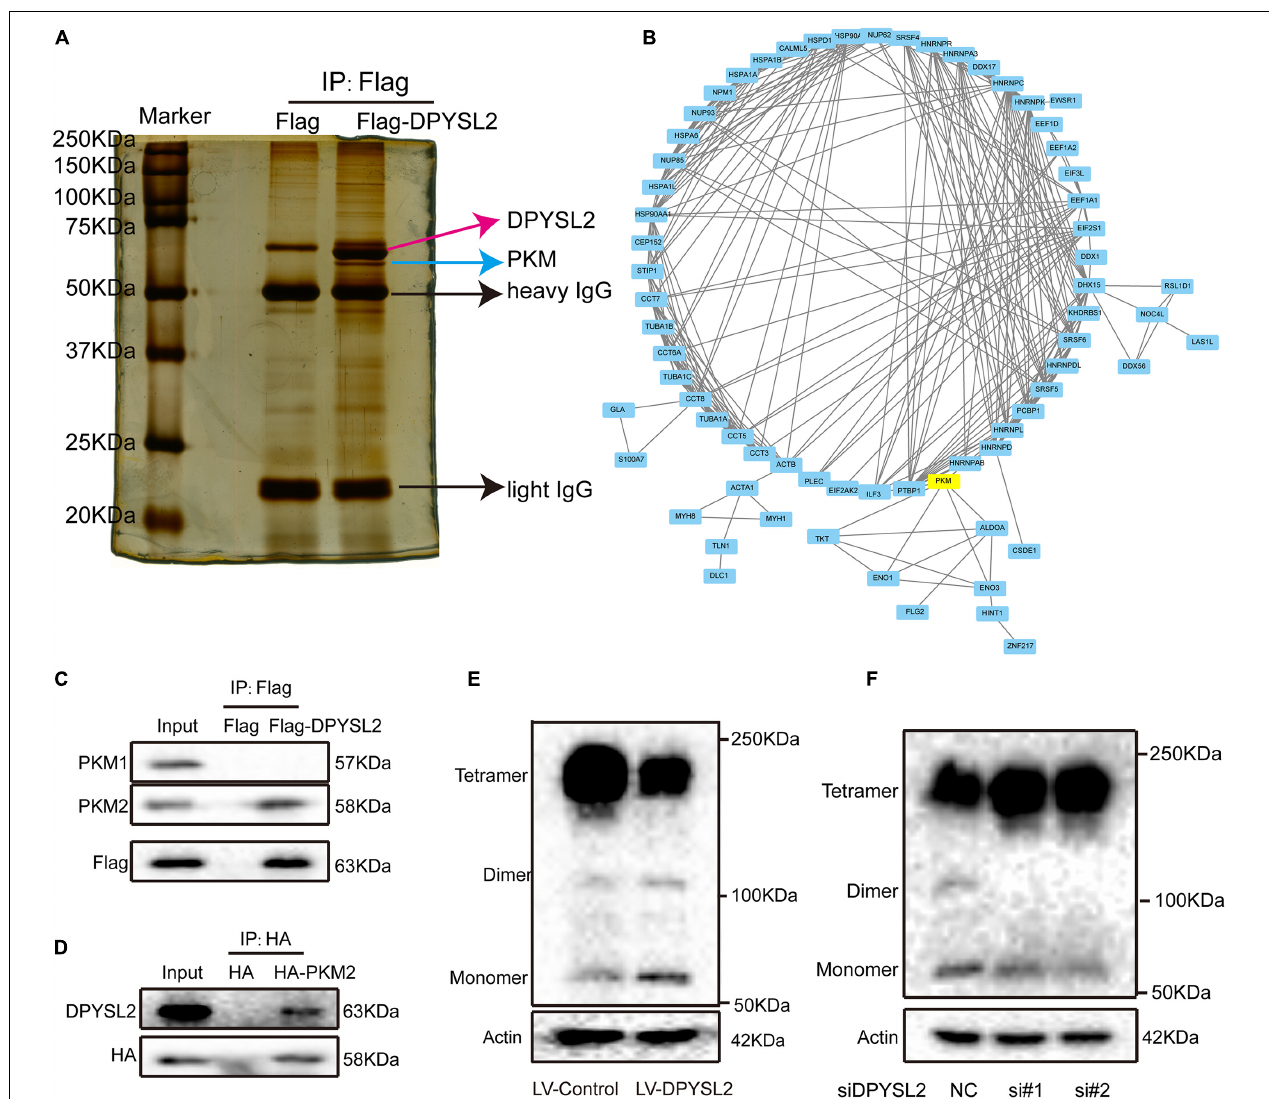
FIGURE 4 | Dihydropyrimidinase like 2 (DPYSL2) interacted with pyruvate kinase M2 (PKM2) in bladder cancer cells. (A) Co-immunoprecipitation (Co-IP), followed by silver staining and mass spectrometry, was performed to identify the proteins that physically interacted with DPYSL2. (B) A protein-protein interaction network was established to predict the interactions of DPYSL2 with potential candidate proteins using the STRING database (https://string-db.org/). (C) HEK293T cells were transfected with Flag or Flag-DPYSL2 plasmids. The Flag-DPYSL2 complexes were co-immunoprecipitated using an anti-Flag antibody, followed by Western blot analysis to detect PKM1 and PKM2. (D) HEK293T cells were transfected with HA or HA-PKM2 plasmids. The HA-PKM2 complexes were co-immunoprecipitated using an anti-HA antibody, followed by Western blot analysis to detect DPYSL2. (E,F) T24 cells were transfected with LV-DPYSL2, siDPYSL2, or corresponding negative control. A cross-link analysis was performed to detect the monomers, dimers, and tetramers of